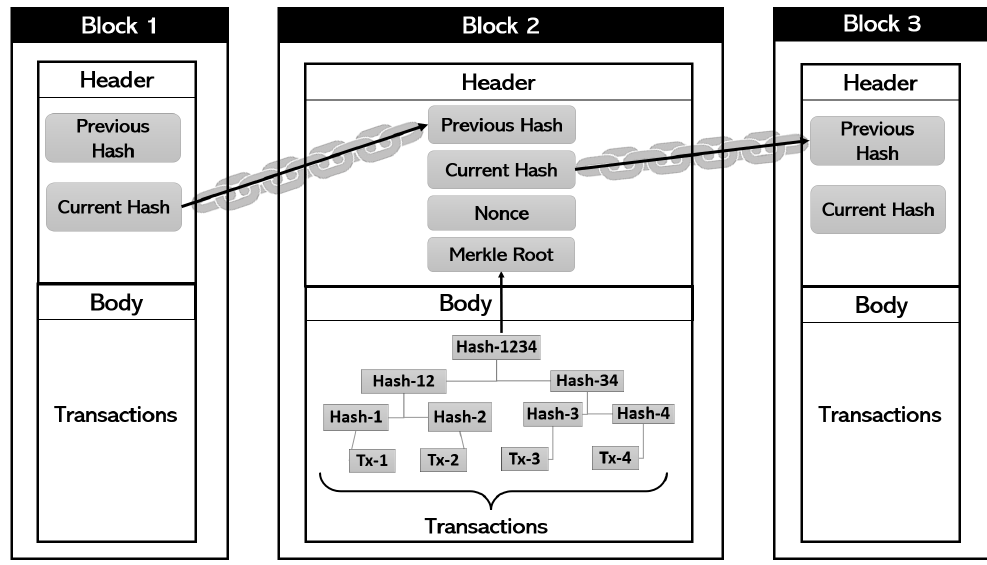
Figure 2. Blockchain general